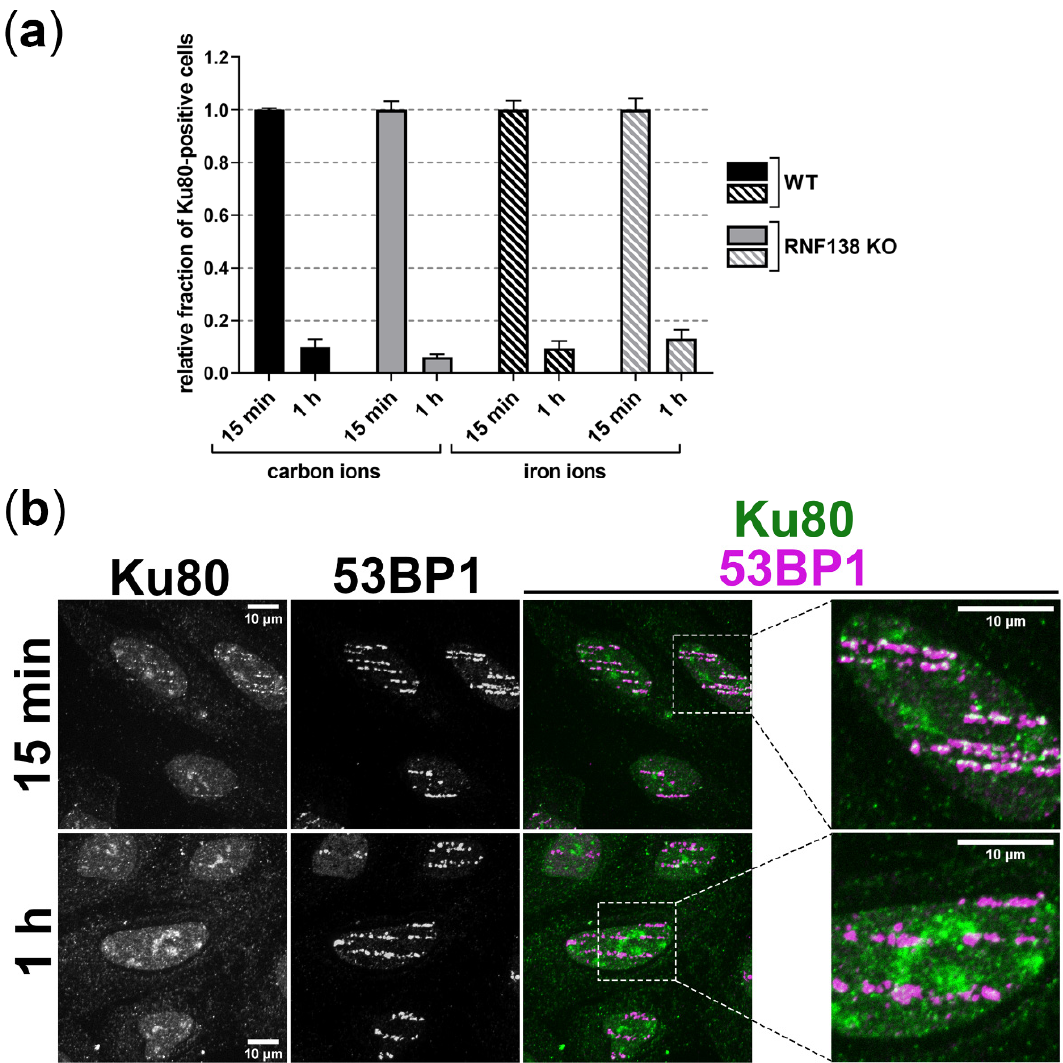
Figure 6. Ku80 vacates complex heavy-ion-induced DSBs independent of RNF138. U2OS cells proficient (wt) or deficient for RNF138 (RNF138 KO) were irradiated in a low angle (5 × 10 6 p./cm 2 ) with low-energy carbon (11.4 MeV/nucleon) or high-energy iron ions and fixed 15 min or 1 h after irradiation. Ku80 and 53BP1 (DSB marker) were immunofluorescence stained. Ku80-positive, irra- diated (53BP1-positive) cells were quantified. Per sample, at least 100 irradiated cells were analyzed and 6–10 fields of view were enumerated in order to average the number of Ku80-positive cells. Within the irradiated area, all cells were hit by ions. n = 1, error = SEM ( a ) Fraction of Ku80-positive cells 15 min or 1 h after irradiation in dependence of RNF138. ( b ) Exemplary images of iron-ion- irradiated wt cells 15 min and 1 h after irradiation and immunofluorescence staining of Ku80 and 53BP1. An enlarged version of the areas highlighted by dashed boxes is shown to the right.